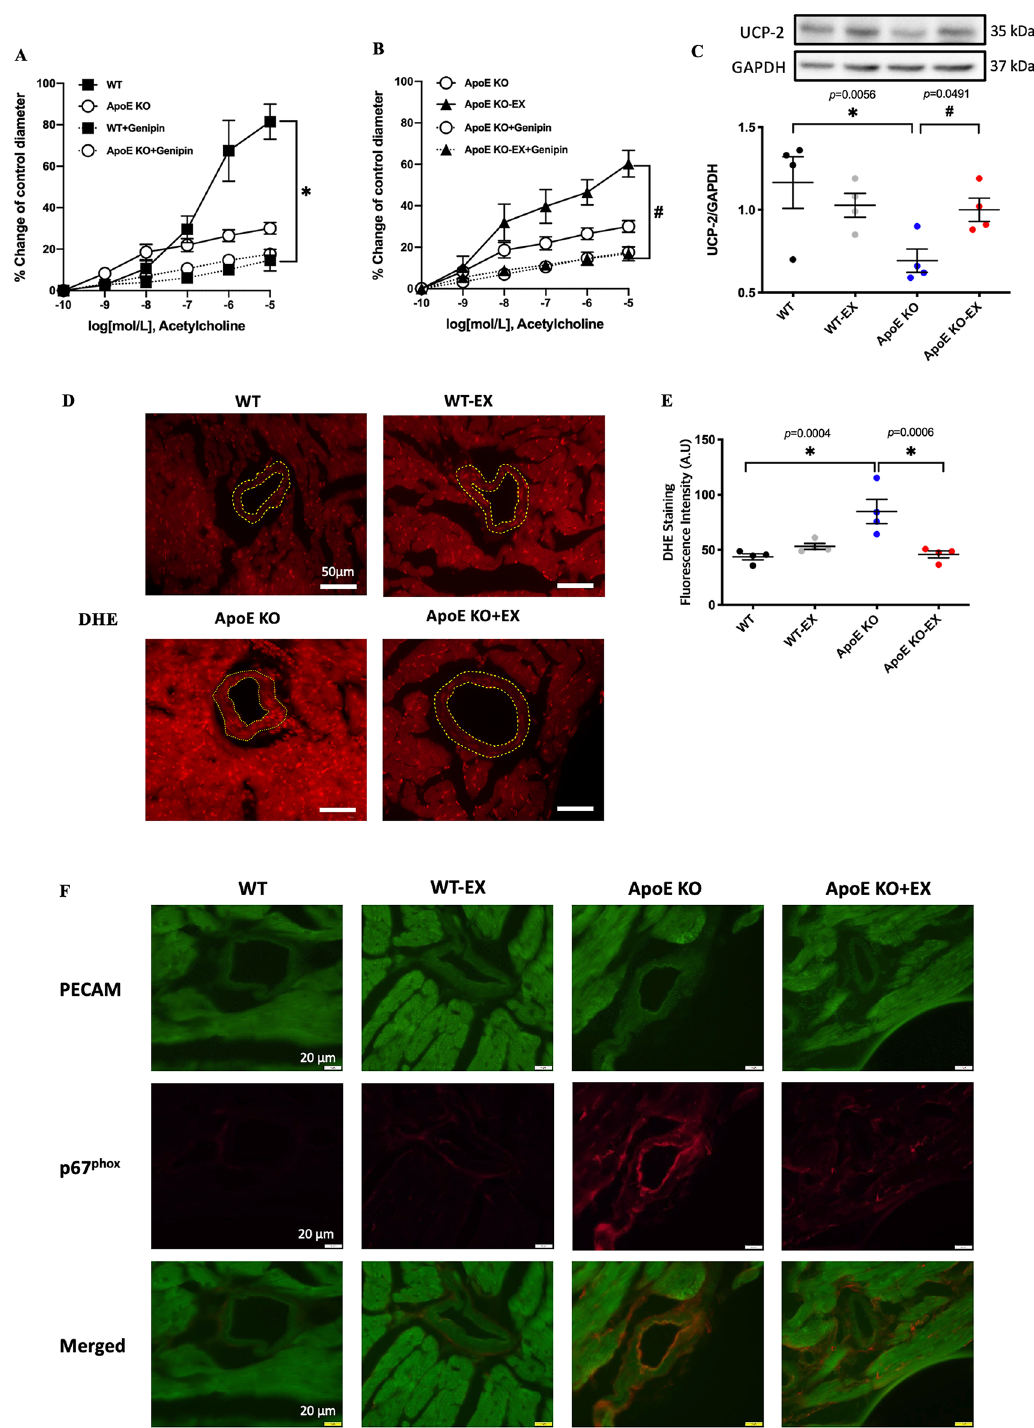
Figure 4. Effect of exercise training on UCP2 deficiency-mediated endothelial dysfunction in coronary arterioles and oxidative stress in the heart of ApoE KO mice. ( A,B ): ACh-induced vasodilation was measured in the present of UCP2 inhibitor (genipin) from isolated coronary arterioles in WT + genipin (n = 4), WT-EX + genipin (n = 4), ApoE KO + genipin (n = 5) and ApoE KO-EX + genipin (n = 4). ( C ): The protein expression of UCP2 was measured by immunoblot analysis from each group (n = 4/groups). ( D ): Representative images of DHE staining from each group. Magnification: × 20. Scale bar = 50 μm. ( E ): Quantified DHE intensity from four independent experiments using the different samples (n = 4/groups). ( F ): Immunofluorescence image of NADPH oxidase subunit p67phox in the coronary arterioles. Magnification: × 40. Scale bar = 20 μm. Values are presented as means ± SEM. * p < 0.05 versus WT, # p < 0.05 versus ApoE